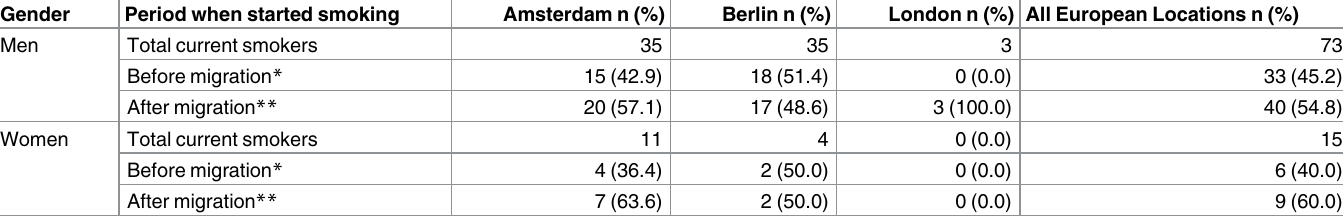
Table 3. Period when first generation current smokersstarted smoking by gender and European location of residence (restricted to those who migrated after age 25). Gender Period when started